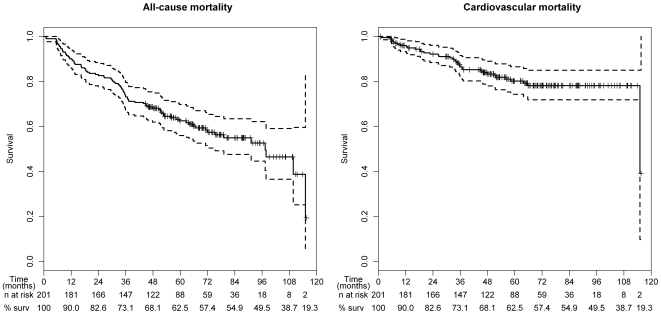
Kaplan-Meier survival curves with 95% confidence bands for all-cause and cardiovascular mortality.“% surv” stands for the percentage of survivors at each 12-month interval.